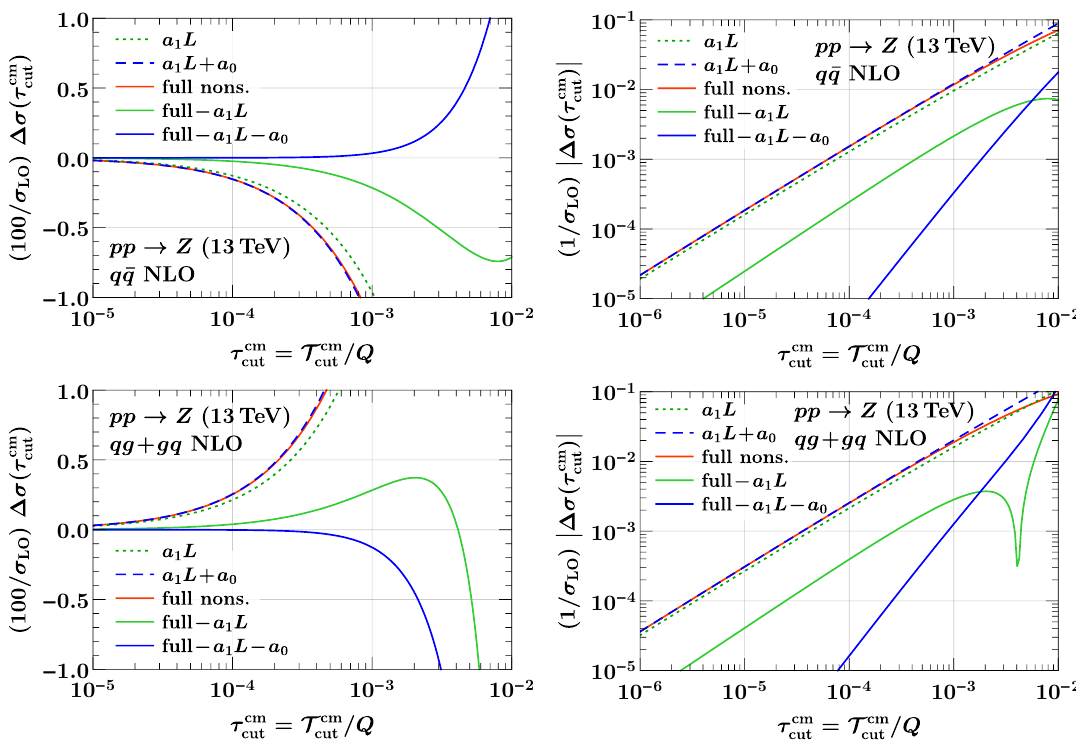
Figure 5 . Same as (cid:12)gure 3 for the hadronic T